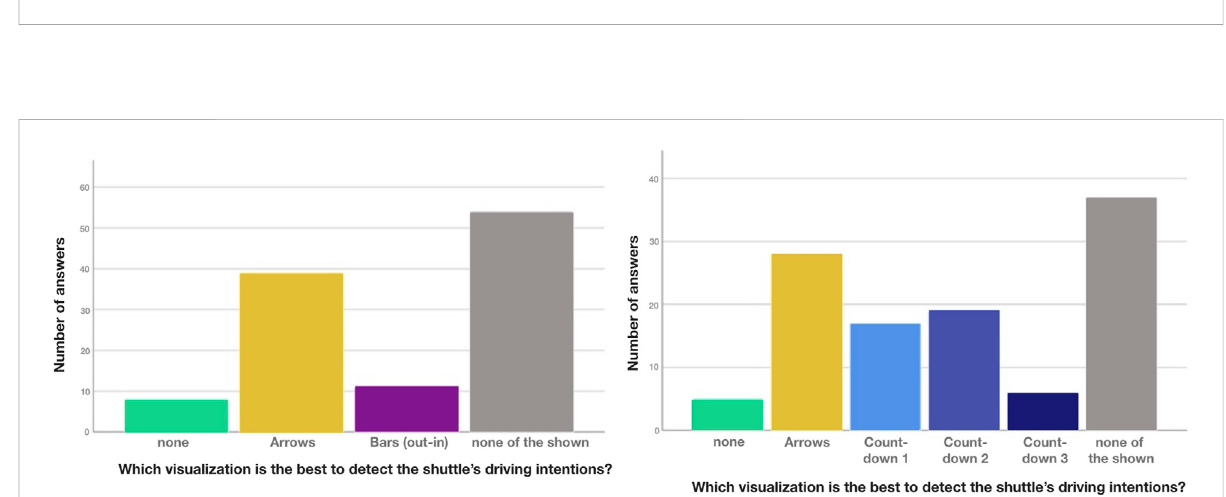
FIGURE 13 Preferred eHMI for detect shuttle ’ s intentions at Unregulated junction 2A and